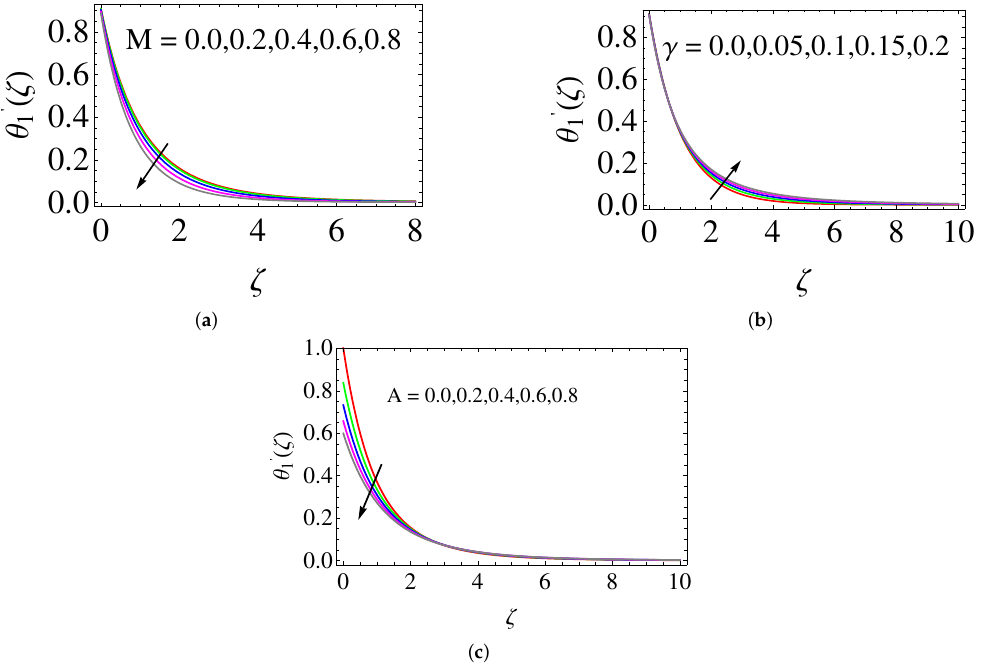
Figure 4. Influences of ( a ) magnetic ( M ) , ( b ) curvature ( γ ) and ( c ) velocity slip parameters ( A ) on the concentration profile for Rd = 0.1, Nt = 0.1, θ w = 0.1, Nb = 0.1, Pr = 1.4, D f = 0.2, Sc n = 1.9, Sc = 0.4, S r = 0.2, C r = 0.1, G 1 = G 2 = G 3 = 0.1 and B 1 = B 2 = B 3 =